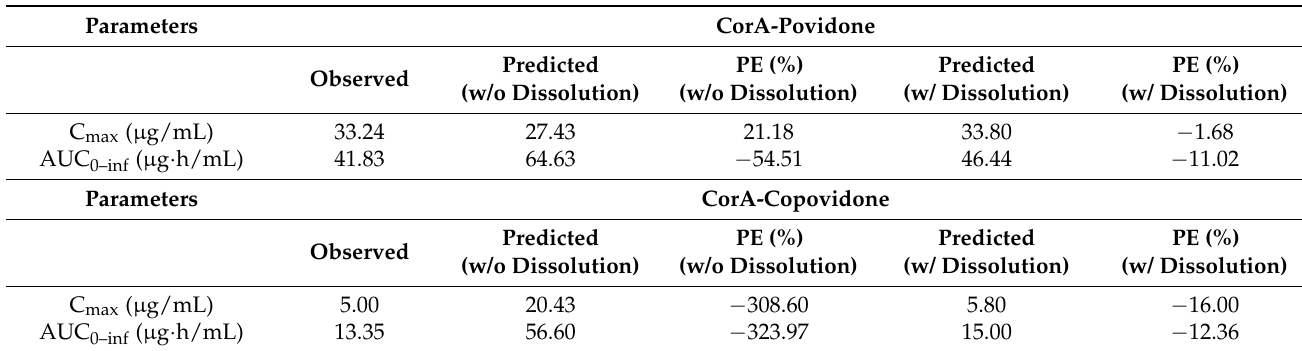
Table 6. Observed and predicted values of C max and AUC 0–inf of CorA-povidone and CorA- copovidone after oral